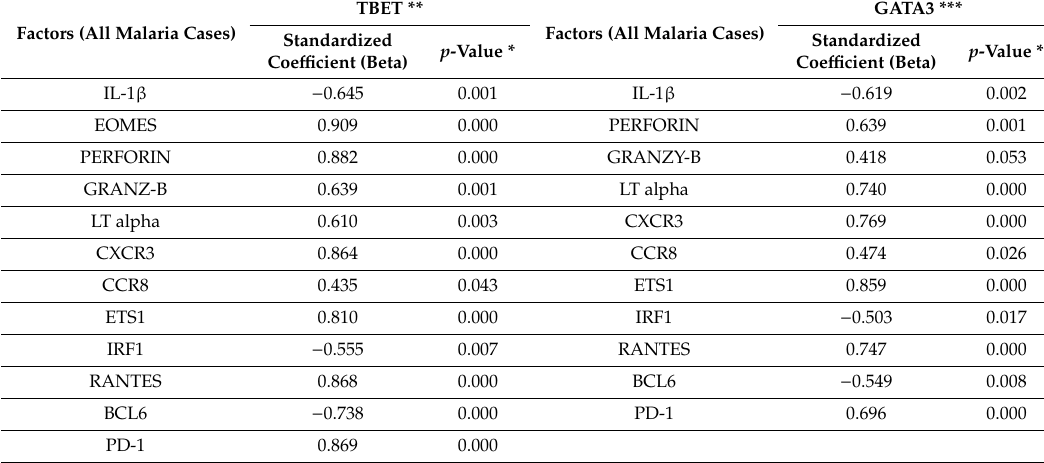
Table 4. Linear regression predictive analysis of immunoregulatory